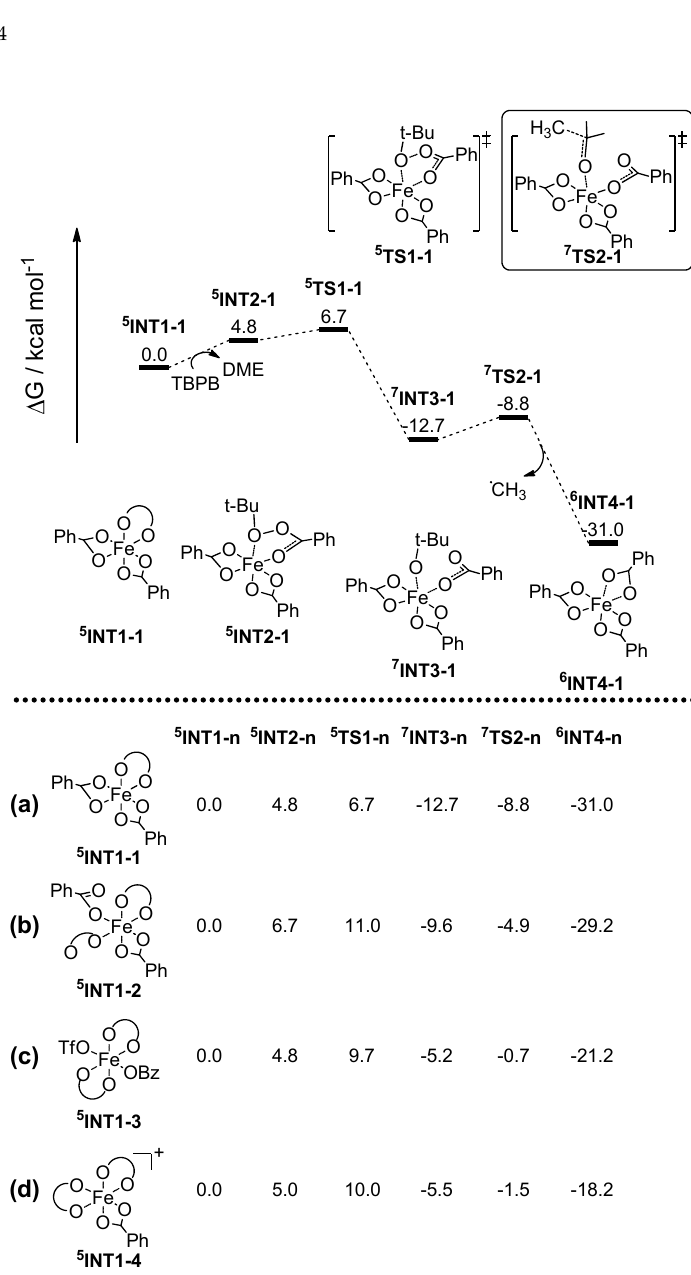
Figure 2. The Gibbs free energy profiles of SET and iron-catalyzed β -methyl scission processes for ( a ) Fe(OBz) 2 (DME), 5 INT1-1 , ( b ) Fe(OBz) 2 (DME) 2 , 5 INT1-2 , ( c ) Fe(OTf)(OBz)(DME) 2 , 5 INT1-3 and ( d ) cation species [Fe(OBz)(DME) 2 ] + , 5 INT1-4 , showing that di ff erent possible Fe(II / III) species